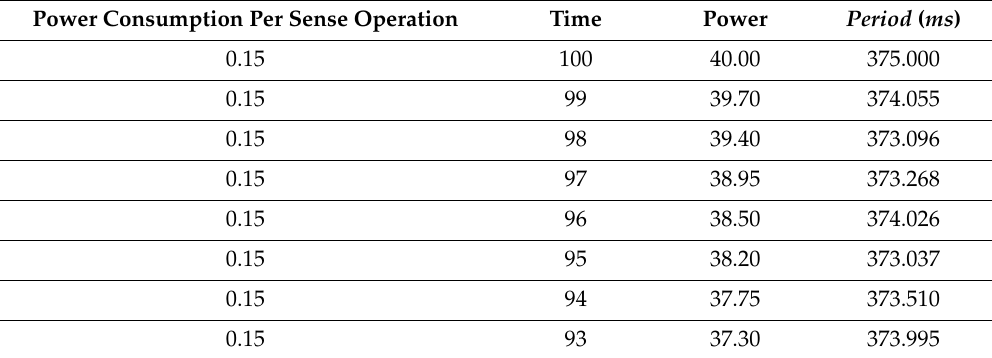
Table 1. Part of learning data for ultrasonic